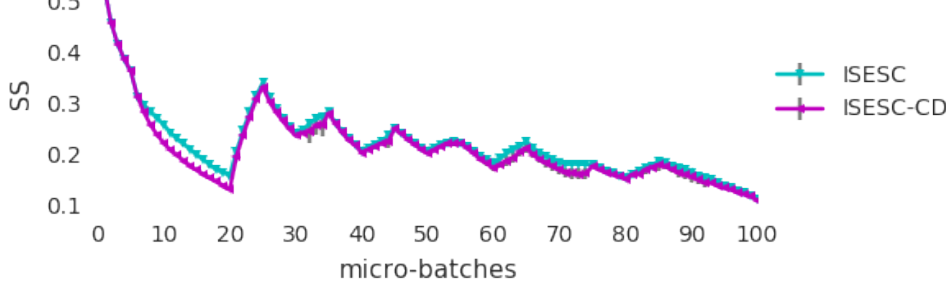
Figure 8. SS comparison—PPA data set. The vertical axis represents the SS score and the horizontal axis represents the micro-batch position.